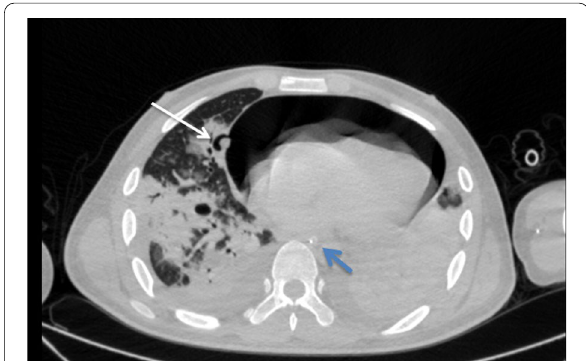
Fig. 4 Non-contrast computed tomography Chest on day 24 of admission shows subsegmental area of consolidation encasing medial segmental bronchus of the right middle lobe, with eccentric cavitation showing transpericardial contiguity.